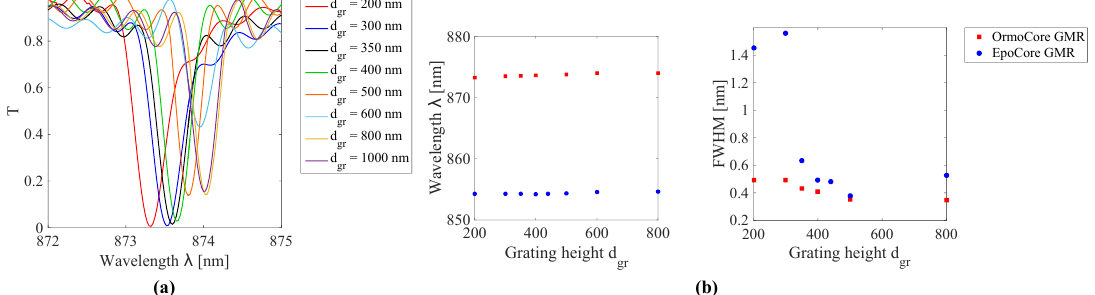
Figure 8. ( a ) Simulated transmission spectra for GMR gratings in EpoCore with varying grating height d gr . ( b ) The simulated resonant wavelength and full width at half maximum (FWHM) as a function of the grating height for the GMR grating in OrmoCore and EpoCore. The used grating parameters are listed in Table